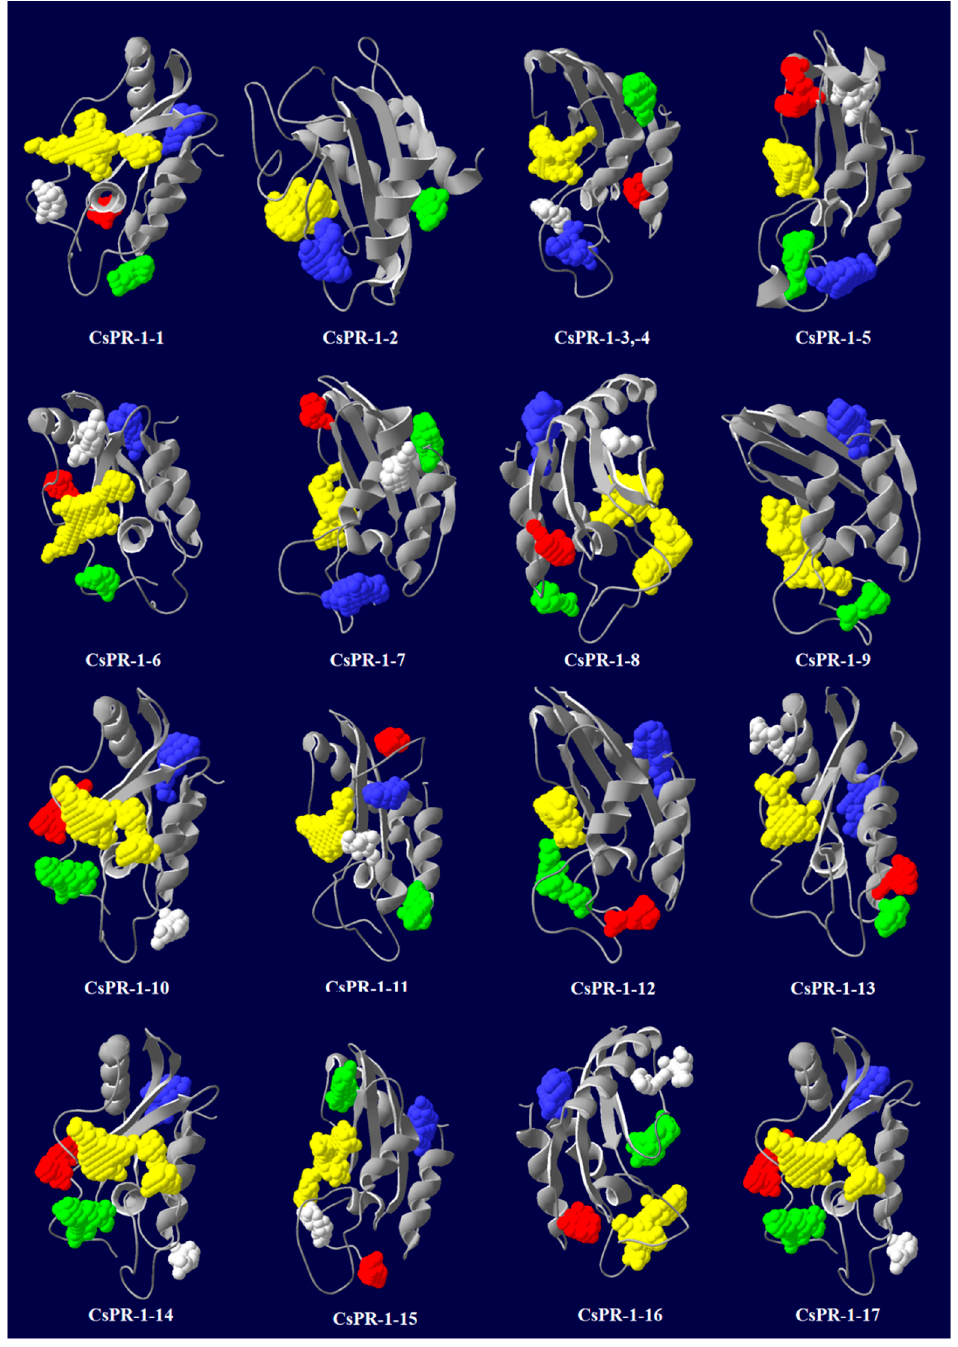
Figure 5. Predicted 3D structure of the CsPR-1 proteins using the Phyre2 server and pockets using the Pasaccca server. The top five predicted pockets are indicated as yellow, blue, green, red, and grey, respectively.